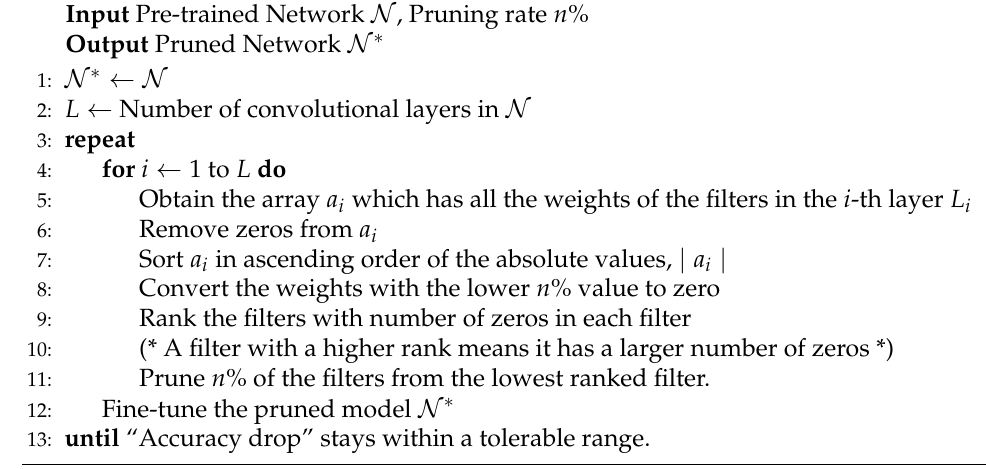
Algorithm 1 Zero-keep filter pruning